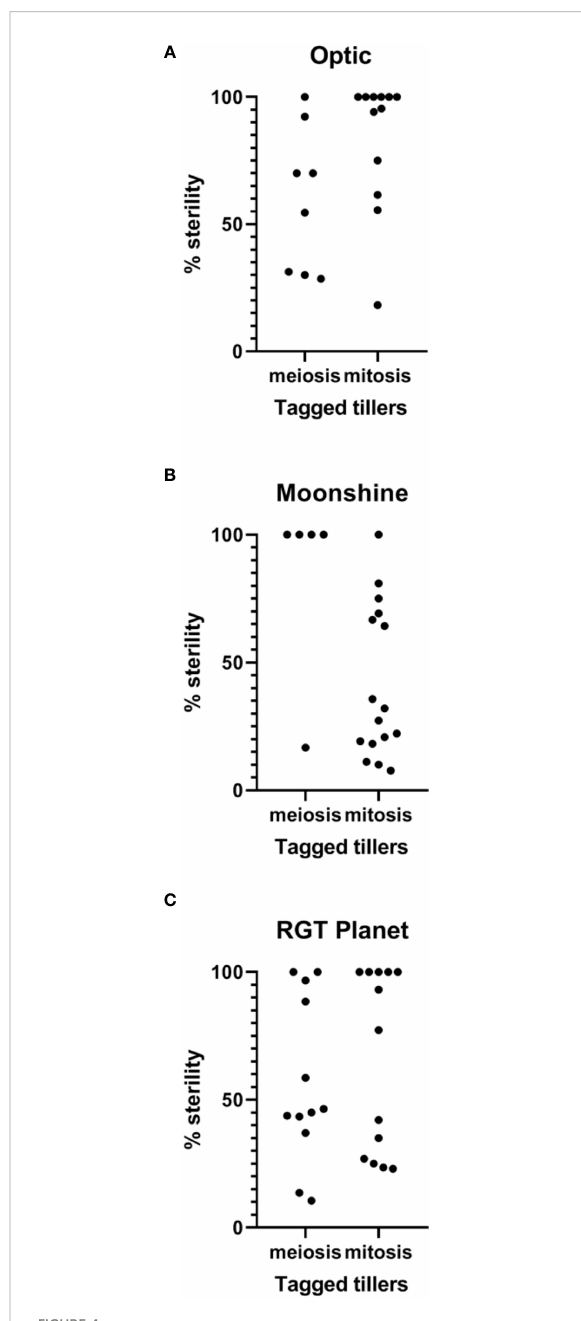
FIGURE 4 Sterility in heat stressed and control conditions in three European barley varieties. Percentage of sterility was calculated for all tillers for all three varieties after PMC meiosis and pollen mitosis heat treatments for (A) Optic (B) Moonshine and (C) RGT Planet. Kruskal-Wallis test was used to determine signi fi cance of difference between varieties and between treatments. All analysis was based upon based upon at least three biological